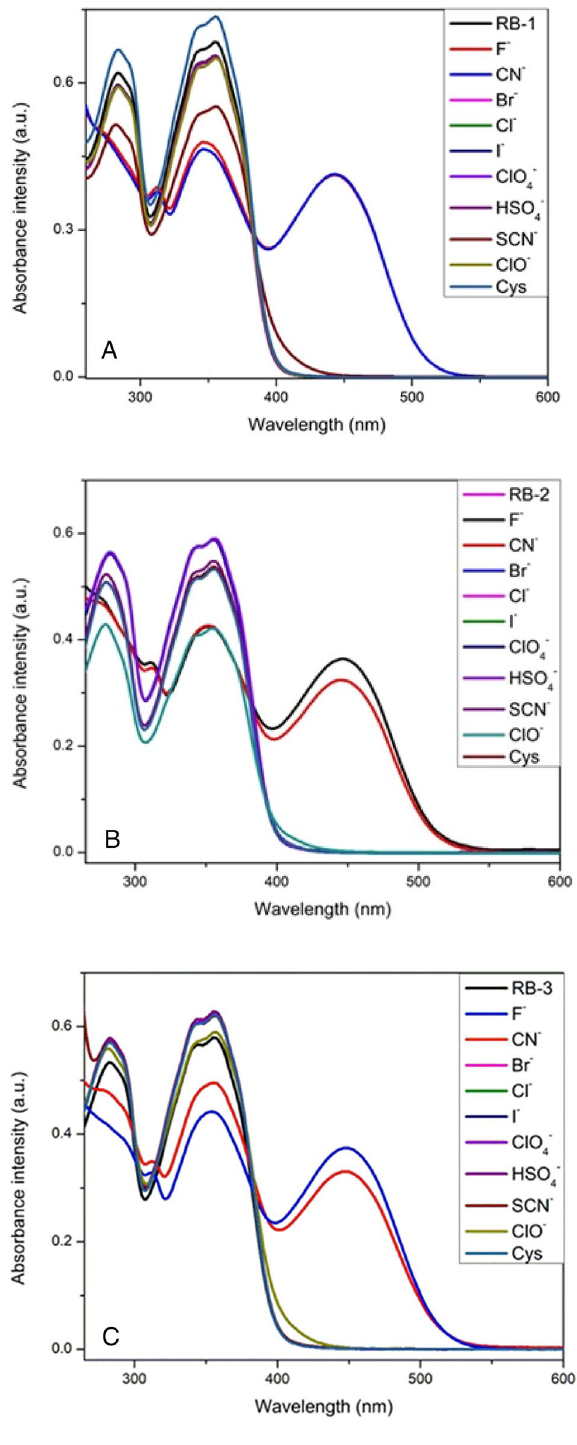
Figure 1. ( A–C ) UV–vis spectra of chemosensors RB-1, RB-2 and RB-3 in CH 3 CN after addition of anions (10